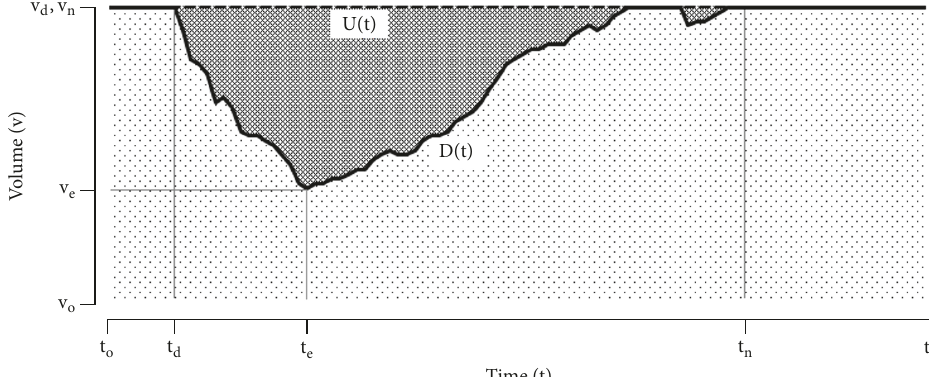
Figure 3: A disaster decreases the volume of delivery over time with the dark gray highlighting the impact of ‘under-delivery’ area, the solid black line (D) indicating the actual volume, and the dashed black line (U) indicating that the expected delivery would not make the disaster happen; encodings for subscripts, ‘d’ for disaster, ‘e’ for the lowest delivery, ‘n’ for normalization, and ‘o’ and ‘c’ mostly technical indicators of the opening and closing the chart.